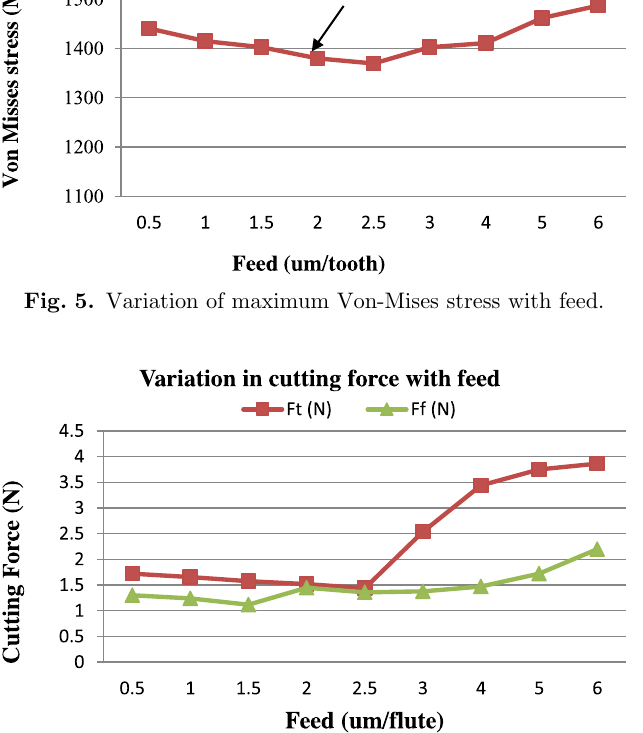
Fig. 6. Variation in tangential force ( F t ) and feed force ( F f ) with feed (simulated results).